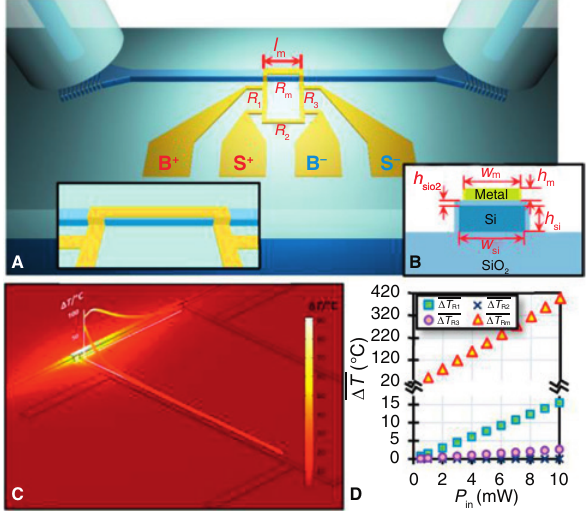
Figure 1: Schematic configuration of the proposed power monitor and the simulated photothermal effect. (A) Three-dimensional schematic configuration of the proposed silicon HPWG power monitor integrated with the Wheatstone bridge circuit. Inset: detail of connection between metal strips and electrodes. (B) Cross-section of the silicon HPWG in the absorption region. (C) Calculated distribution of temperature increase in the whole structure when 1 mW optical power is received. Here, the increased temperature distribution in the metal strips on the silicon HPWG as well as on the substrate is also shown. (D) Calculated average temperature variations ∆ the four metal strips ( R , R , R , and R ) as the input optical power 1 2 3 m = 400 nm, P increases. Here, the parameters are chosen as w in m